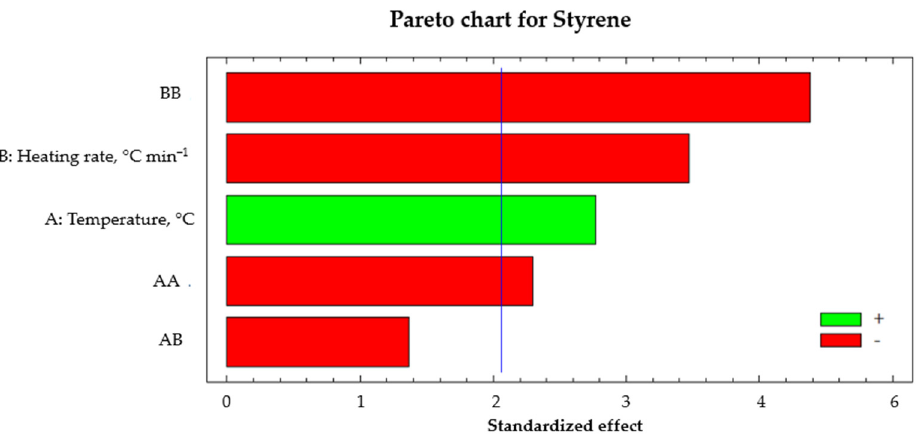
Figure 8. Standardized Pareto chart for styrene production.